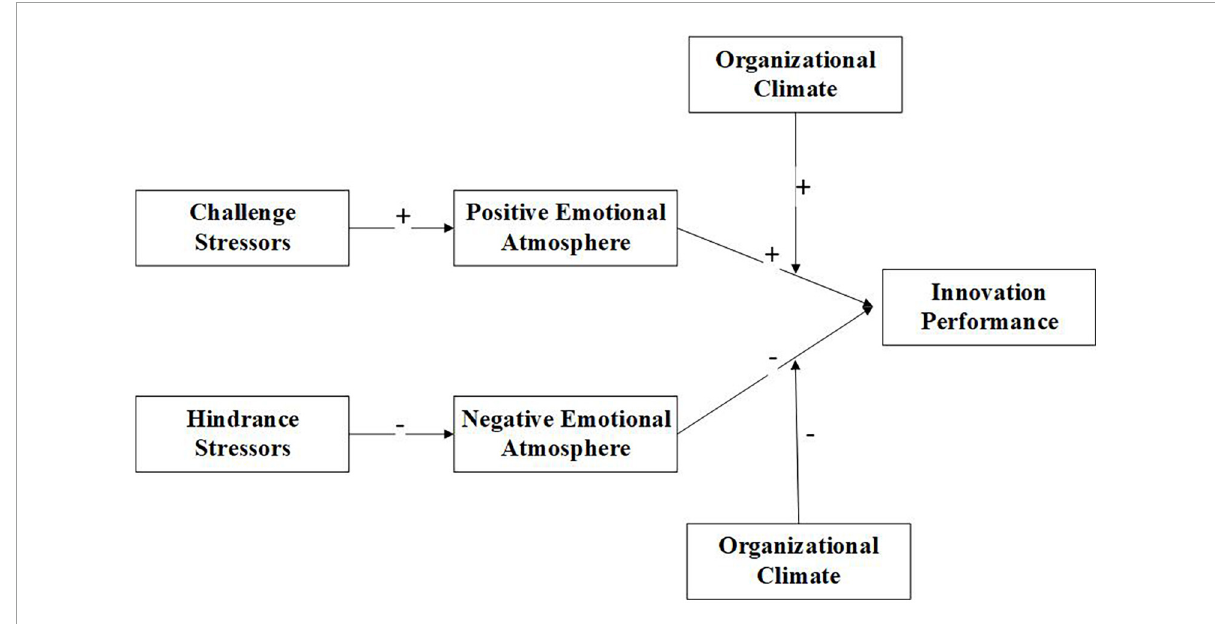
FIGURE1 Theoretical